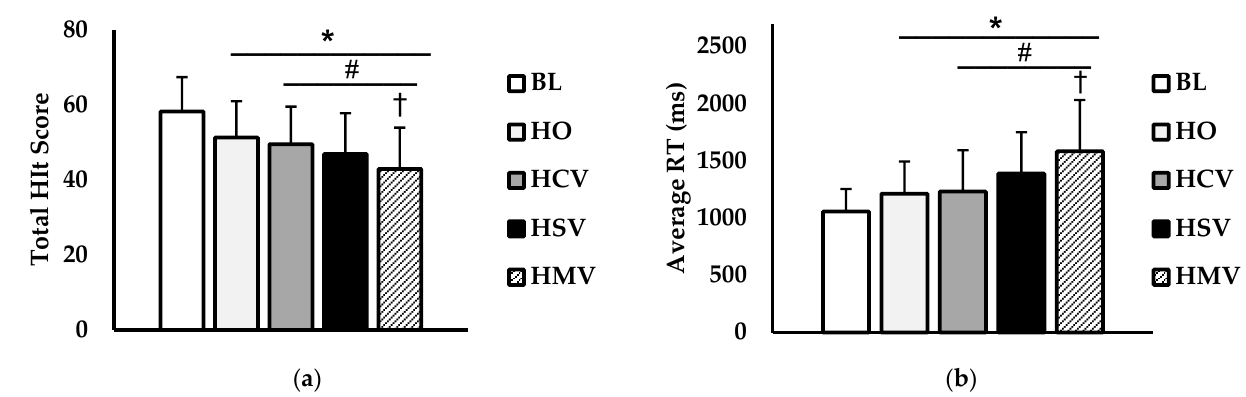
Figure 5. Comparison of ( a ) total hit score, ( b ) average reaction time (ms) between baseline (BL; white), helmet only (HO; light grey), helmet + clear visor (HCV; grey), helmet + smoke tinted visor (HH; black), and helmet + extra heavy (HXH; black striped) conditions. Data are presented as mean ± SD. * indicates significant difference from baseline ( p < 0.05). # indicates significant difference from HO ( p < 0.05). † indicates signi fi cant di ff erence from clear ( p < 0.05).